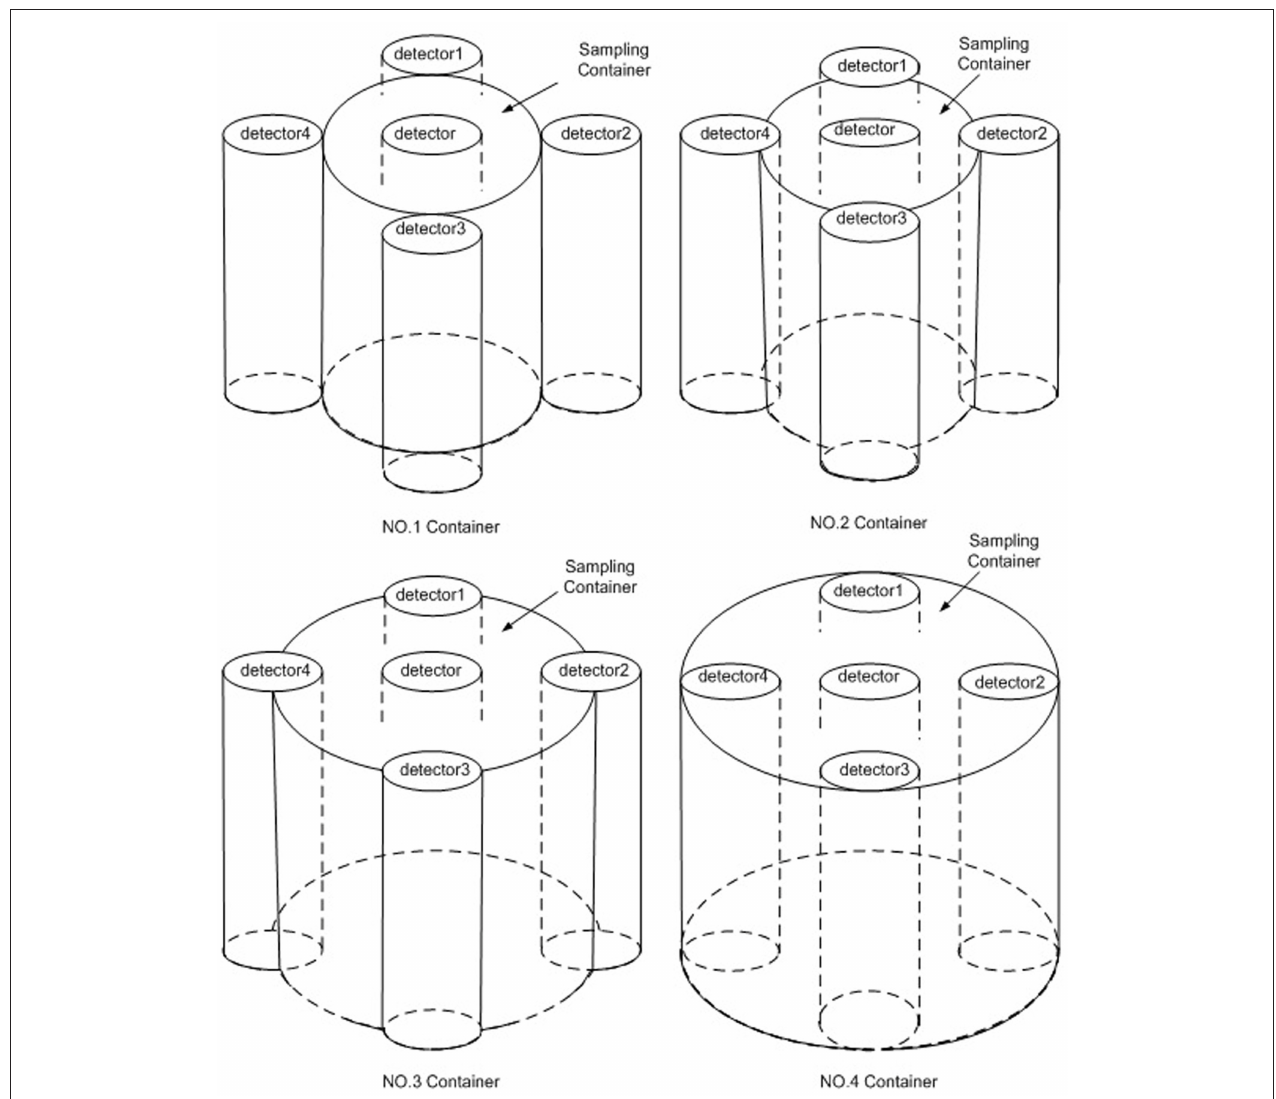
FIGURE 1 | Diagram of the sampling